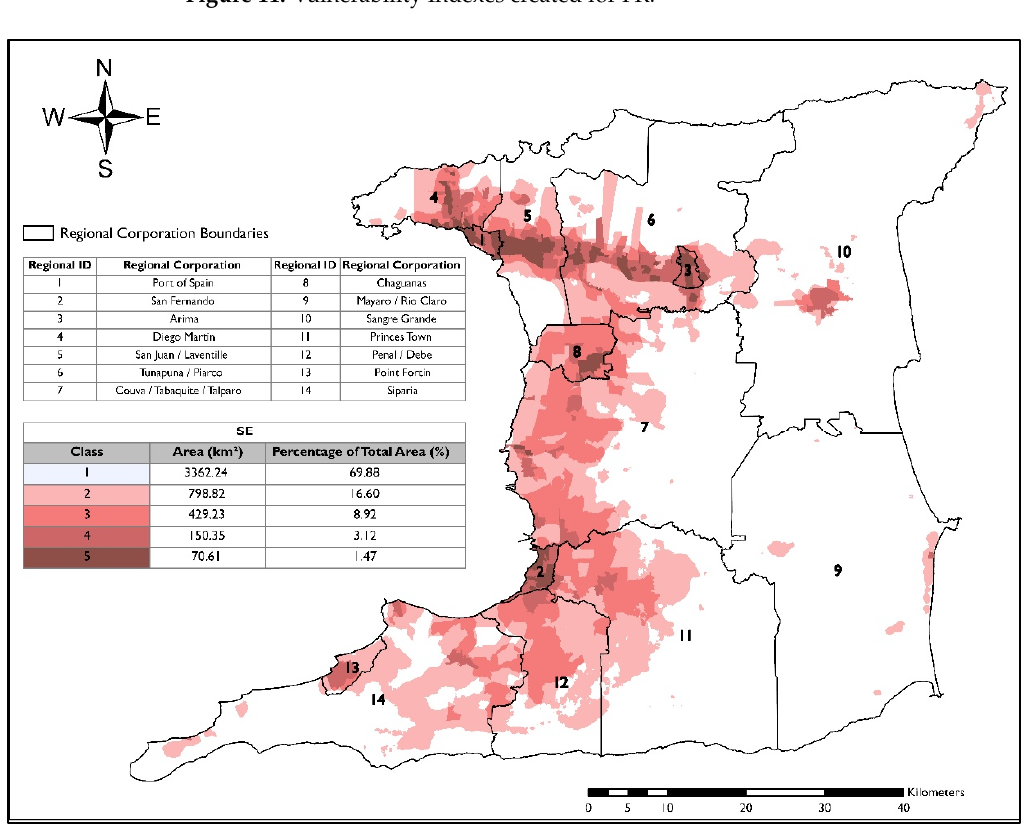
Figure 12. Vulnerability Indexes created for SE.